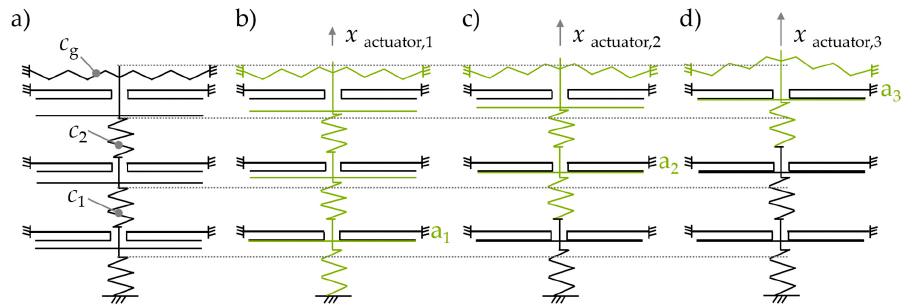
Figure 9. An actuator with three steps: ( a ) initial position, ( b ) the first actuator a 1 is activated and the resulting system displacement is x actuator,1 , ( c ) the actuators a 1 and a 2 are activated, the system displacement being x actuator,2 , ( d ) all actuators a 1 , a 2 and a 3 are activated, resulting in the system displacement x actuator,3 .